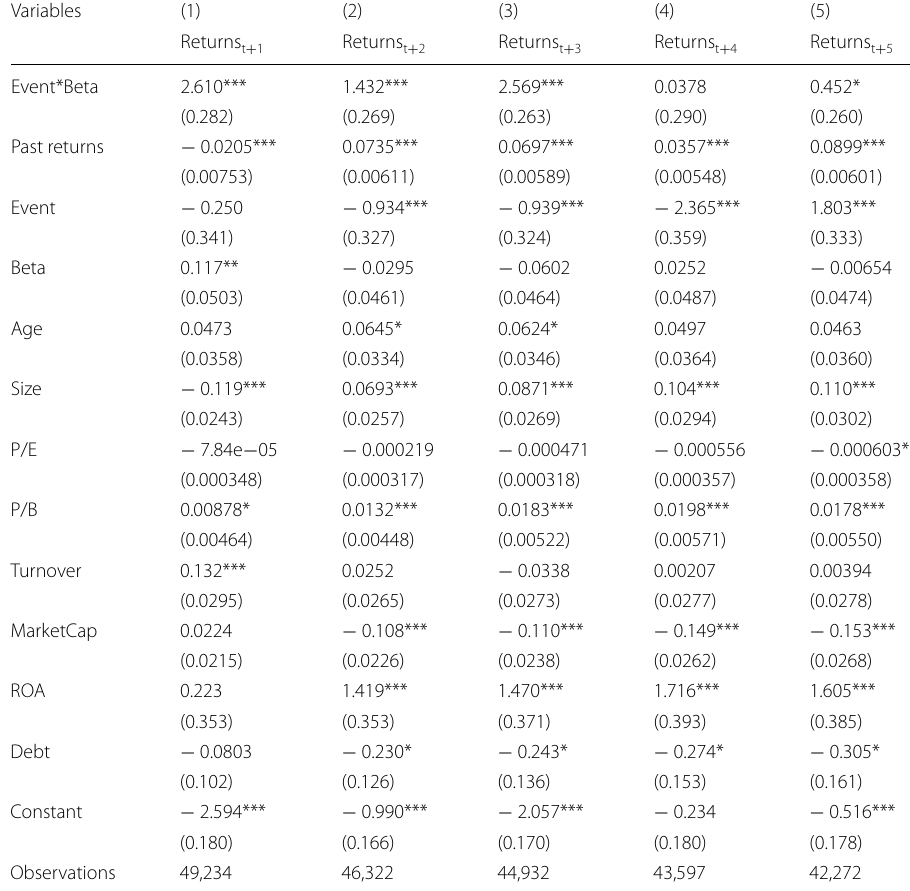
Table 2 Light a lamp, beta and